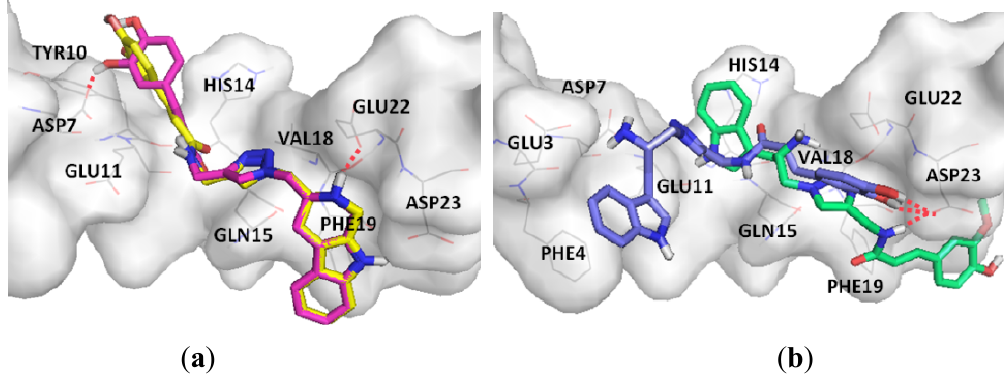
Figure 5. The binding modes of compounds with amyloid- β (1-42); ( a ) 6g (yellow) and 6h (pink); ( b ) 12g (green) and 12h